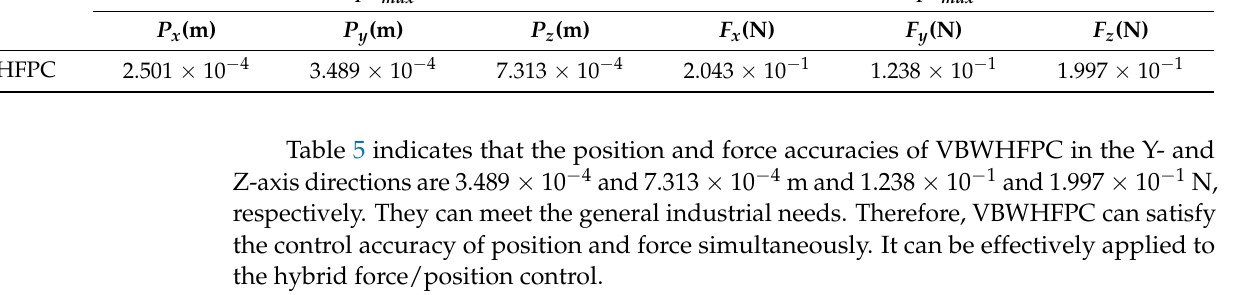
Table 5. Position and force accuracies during the transport operation.